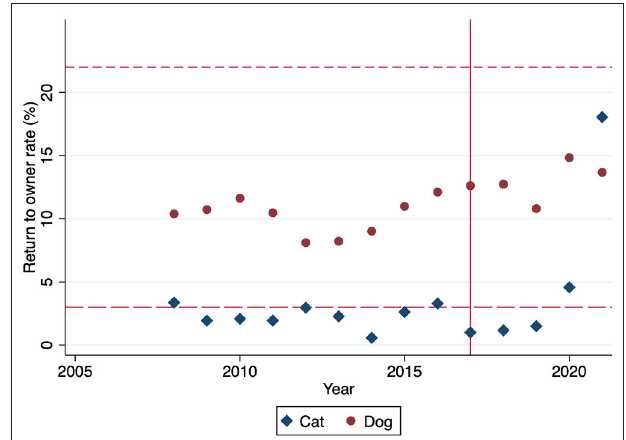
FIGURE 3 | Percent of kittens entering the shelter < 5 months of age euthanized by year. Solid line at intervention year. dogs entering the shelter ( P = 0.001) in the linear portion of the